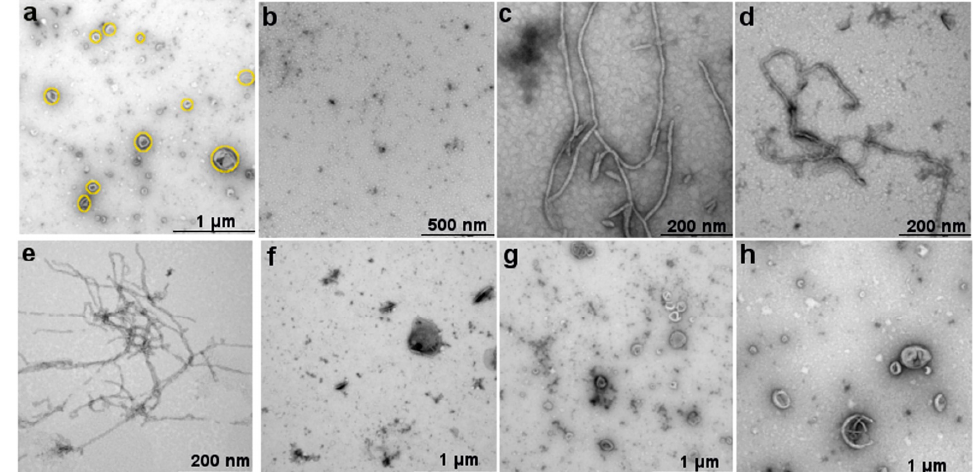
Figure 4. ( a ) TEM images of liposomes before peptide injection (yellow circles); ( b ) LL-37 alone; the effect of 10 μΜ LL-37 on ( c ) neat DMPC; ( d ) DMPC:DMPG (4:1); ( e ) DMPC:DMPG (3:2); ( f )